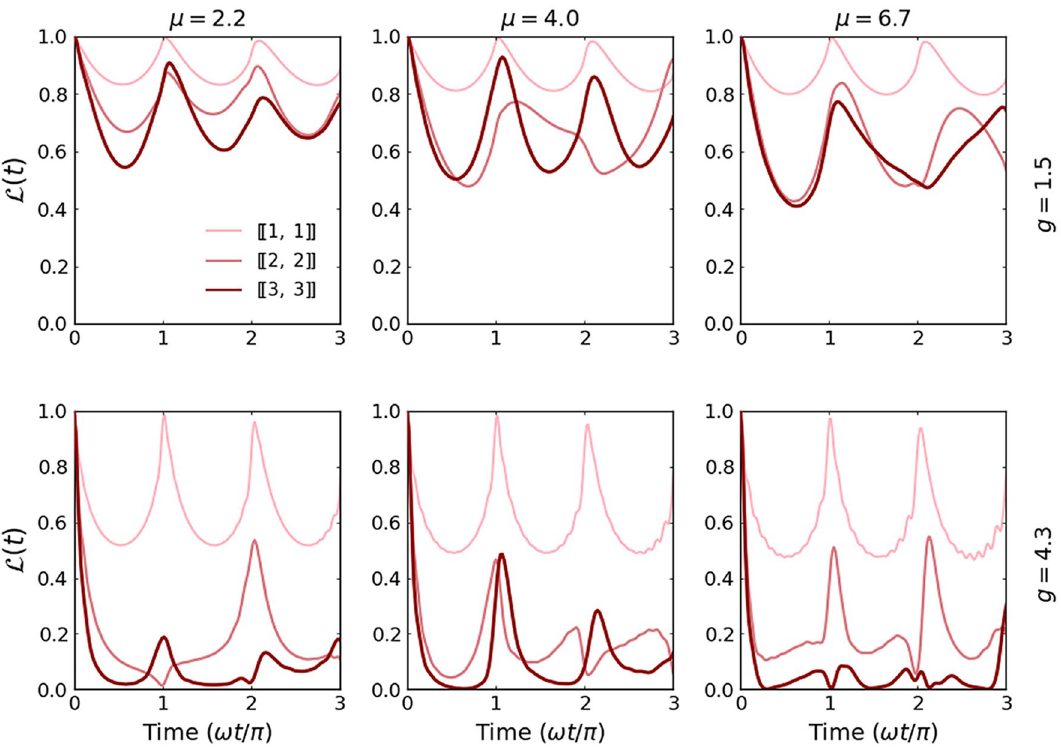
Figure 3. Time evolution of the Loschmidt echo L ( t ) of systems with an equal number of particles in N / 2, N / 2 both components, . Clearly, the behavior of the minimal system with N [[ ]] independent of the mass imbalance at a given quench strength. For larger systems, the Loschmidt echo drops faster and deeper for systems with stronger